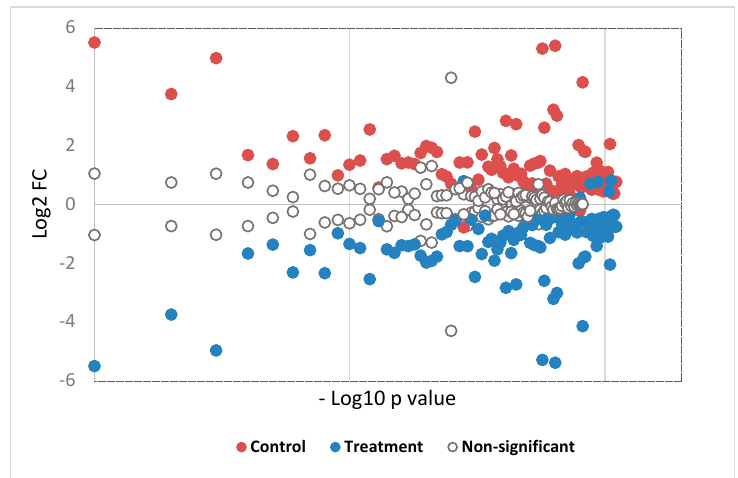
Figure 5. ( A ) Heatmap representing differences in the levels of expression/phosphorylation of NF- κ B—related proteins in MDA-MB-231 cells exposed to Spalax CM (Treated) compared to control; ( B ) Volcano plot representing the log2 FC (treatment/control) versus -log10 p value (cut-off range— p value ≤ 0.05). Dots represent individual proteins.